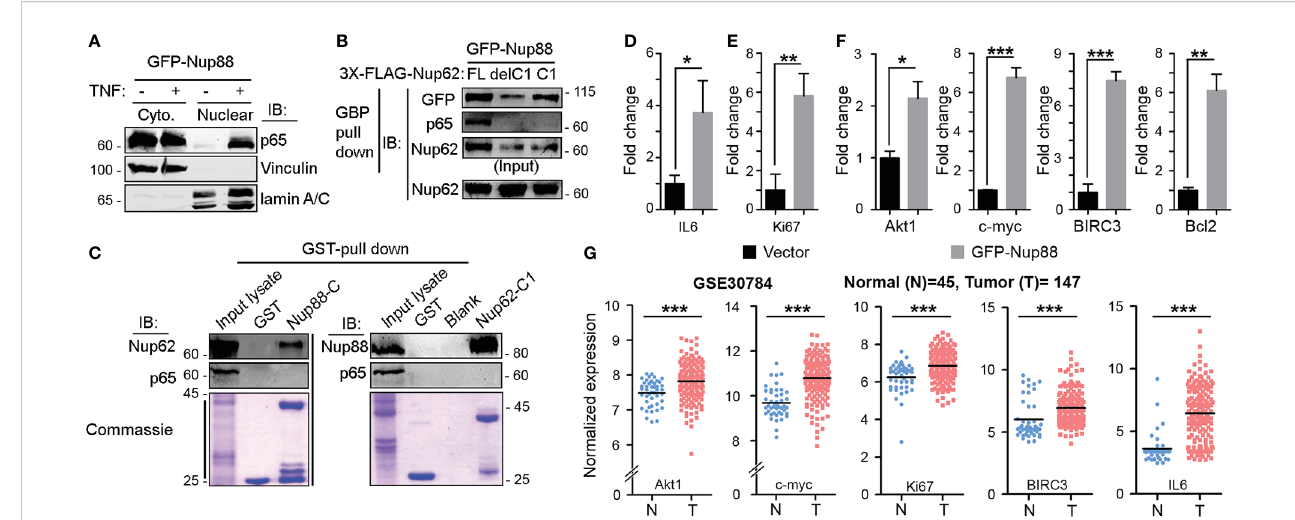
FIGURE 6 Stable Nup88 interacts with NF- k B and activates downstream pathways. (A) Cytosolic and nuclear fractions from GFP-Nup88 expressing cells treated (+) or not-treated (-) with TNF- a immunoblotted with anti-p65, anti-vinculin, and anti-lamin A/C antibodies. (B) GBP pulldown from GFP-Nup88 expressing cells cotransfected with FLAG-Nup62 constructs indicated above the lanes. The pulldown material was probed with anti-GFP, anti-p65, and anti-Nup62 antibodies. (C) Beads coated with GST-tagged proteins indicated on top of the wells were used in pulldown from cell lysates. Pulldown material was immunoblotted with anti-Nup62, anti-Nup88, and anti-p65 antibodies. Lower panels show Coomassie of input lysates and bead-bound samples. (D, E) Rps16 normalized qRT-PCR data for IL-6 and Ki67 from GFP-Nup88 transfected cells. (F) Actin normalized qRT-PCR data of indicated target genes from GFP-Nup88 expressing cells. All experiments were carried out in HEK293T cells. (G) IL-6, Ki67, Akt, c-myc, and BIRC3 expression analyzed through microarray data analysis of publically available oral cancer dataset (GSE30784) on GEO database. Error bars indicate mean values ± SEM. Asterisks indicate statistical signi fi cance (Student ’ s t-test) *p < 0.05, **p < 0.01 and ***p <